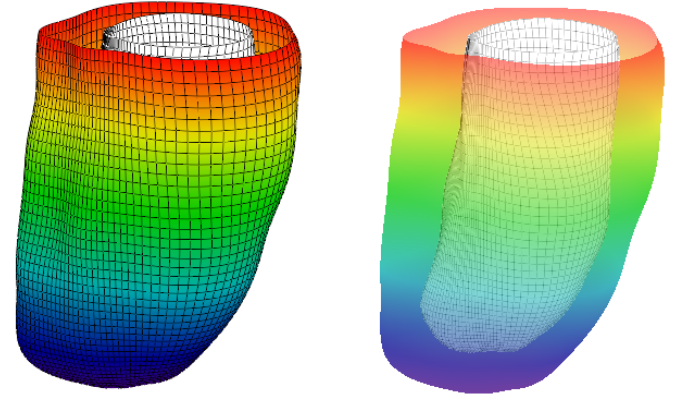
Figure 4. Epicardial and endocardial surfaces of the model that was constructed based on DT-MRI data. ( left ) The epicardium is opaque; ( right ) The epicardium is semi-transparent. Color shows z -coordinates.